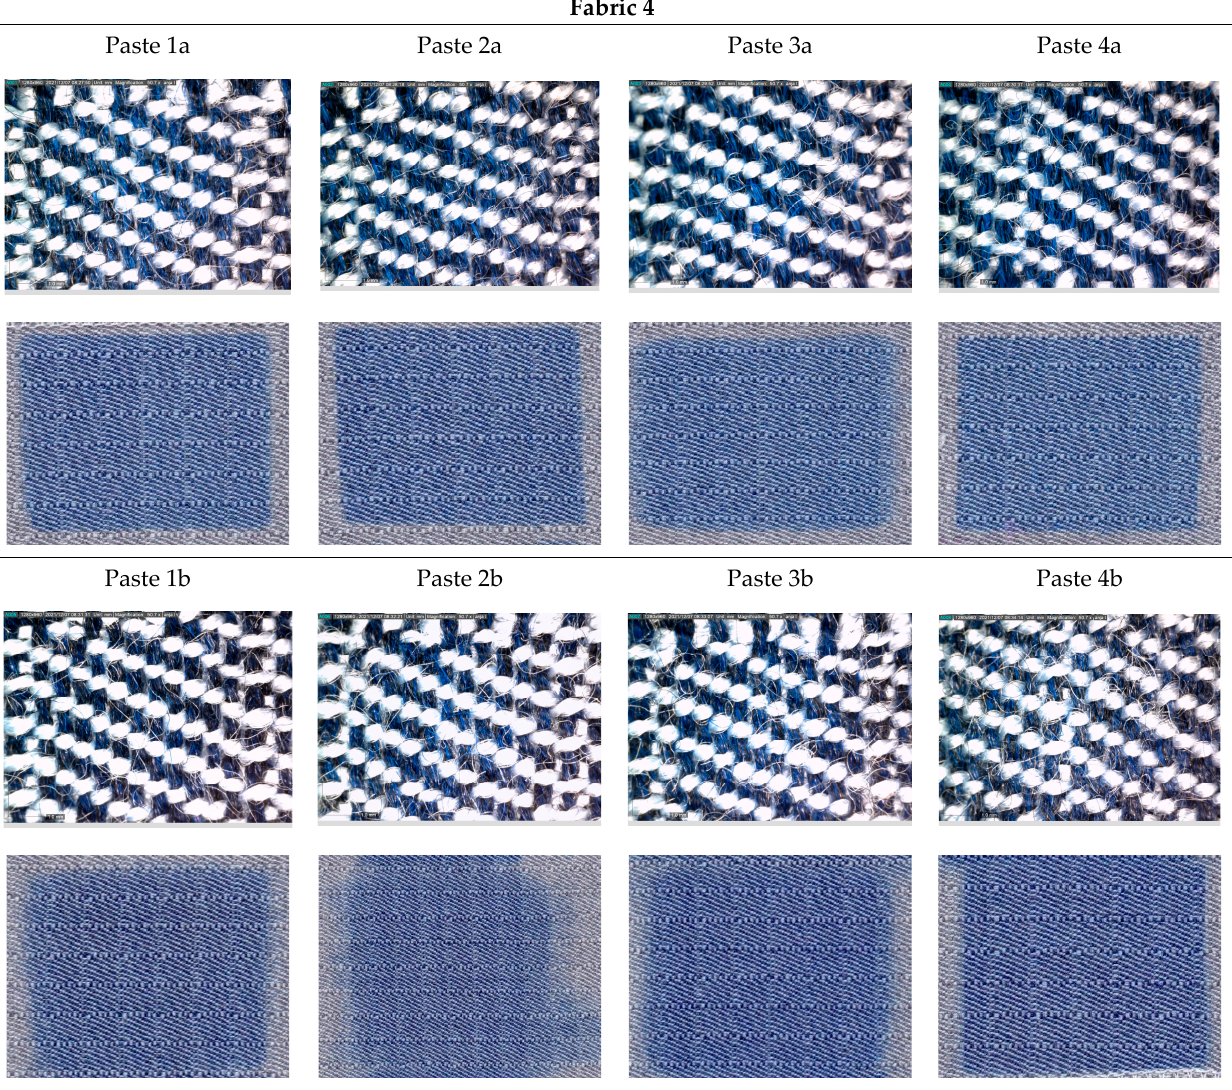
Figure 4. DinoLite microscopic and scanned images of printed Fabric 4.